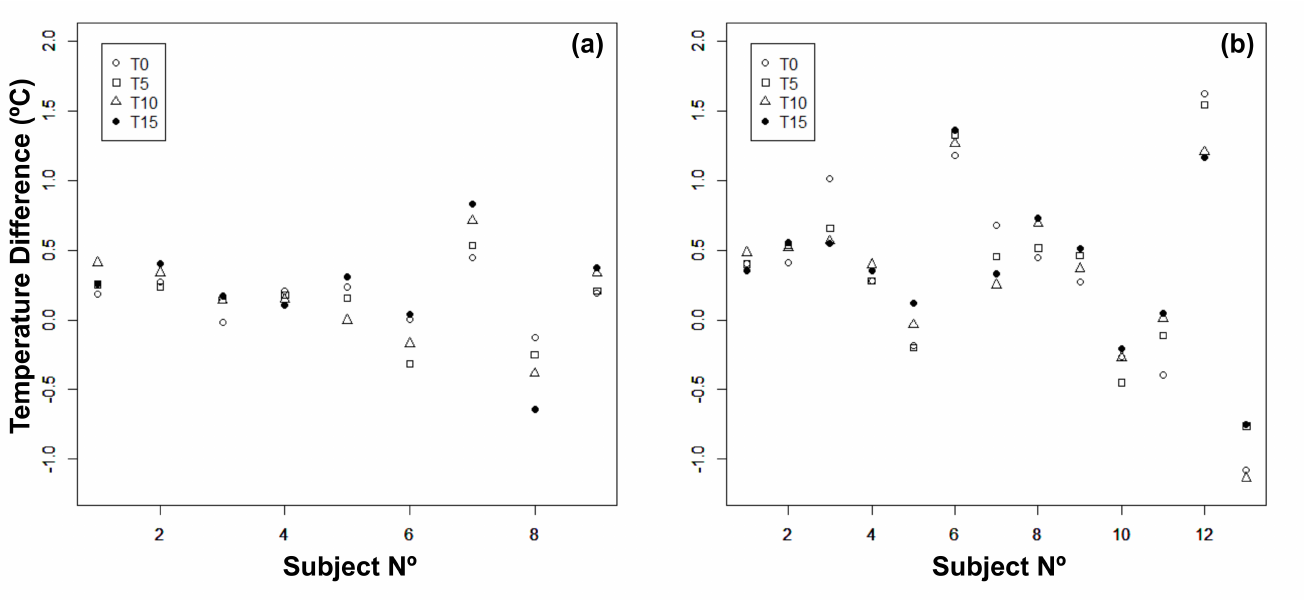
Figure 8. Individual mean temperature difference, left minus right foot, at each time point: ( a ) female and ( b ) male